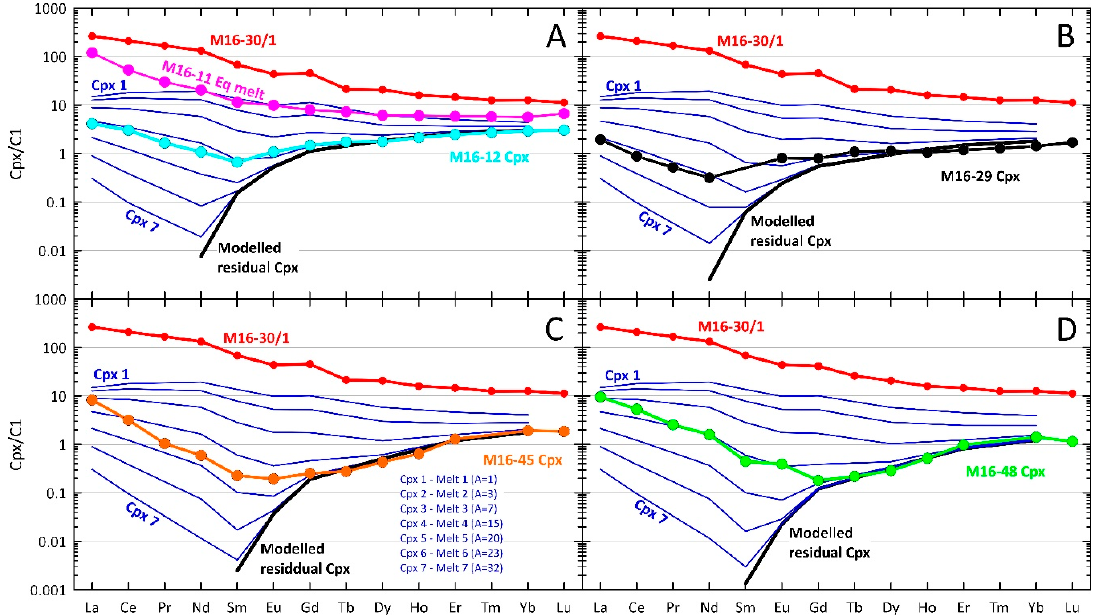
Figure 12. Simulation of REE variations of clinopyroxene in the Alag Khadny peridotites, samples M16-12 ( A ), M16-29 ( B ), M16-45 ( C ), M16-48 ( D ). The modeling parameters, partition coefficients, and simplified equation are from [70]. The modeling assumes redistribution of REE by reaction between percolating melt (sample M16-30/1, dike of calc-alkaline basalt cutting Alag Khadny peridotites) and clinopyroxene in residual harzburgite (modeled residual Cpx for each sample from Figure 8). “A” represents Cpx/melt ratio; Cpx 1 to Cpx 7—equilibrium Cpx for evolved Melt 1 to Melt 7, respectively. Normalized to chondrite [52]. Modeling parameters and results are given in Supplementary Table S3.